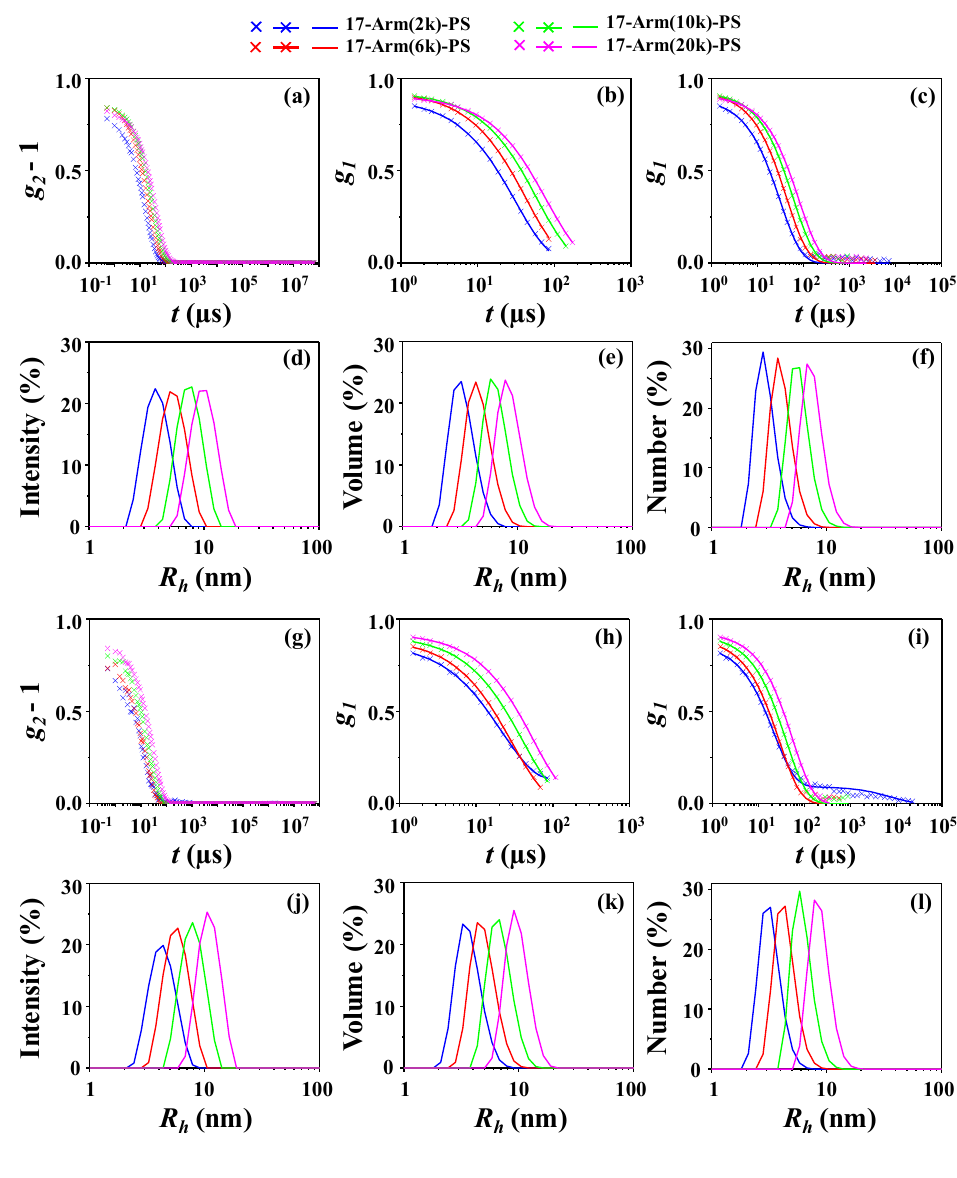
Figure 9. Dynamic light scattering (DLS) analyses of 17-armed star polystyrenes: ( a ) autocorrelation profiles measured in CHX at 35.0 ° C ( Θ condition); ( b ) analysis results of the data in ( a ), where the symbols are the measured data and the red solid lines were obtained by analysis using the cumulant method; ( c ) analysis results of the data in ( a ), where the symbols are the measured data and the red solid lines were obtained by analysis using the non-negatively constrained least square (NNLS) deconvolution algorithm; ( d ) intensity-weighted radius distributions obtained by the data analyses in ( c ); ( e ) volume-weighted radius distributions obtained from the radius distributions in ( d ); ( f ) number-weighted radius distributions obtained from the radius distributions in ( d , e ); ( g ) autocorrelation profiles measured in THF at 25.0 ° C (good solvent); ( h ) analysis results of the data in ( g ), where the symbols are the measured data and the red solid lines were obtained by analysis using the cumulant method; ( i ) analysis results of the data in ( g ), where the symbols are the measured data and the red solid lines were obtained by analysis using the NNLS deconvolution algorithm; ( j ) intensity-weighted radius distributions obtained by the data analyses in ( i ); ( k ) volume-weighted radius distributions obtained from the radius distributions in ( j ); ( l ) number-weighted radius distributions obtained from the radius distributions in ( j,k ). 4.